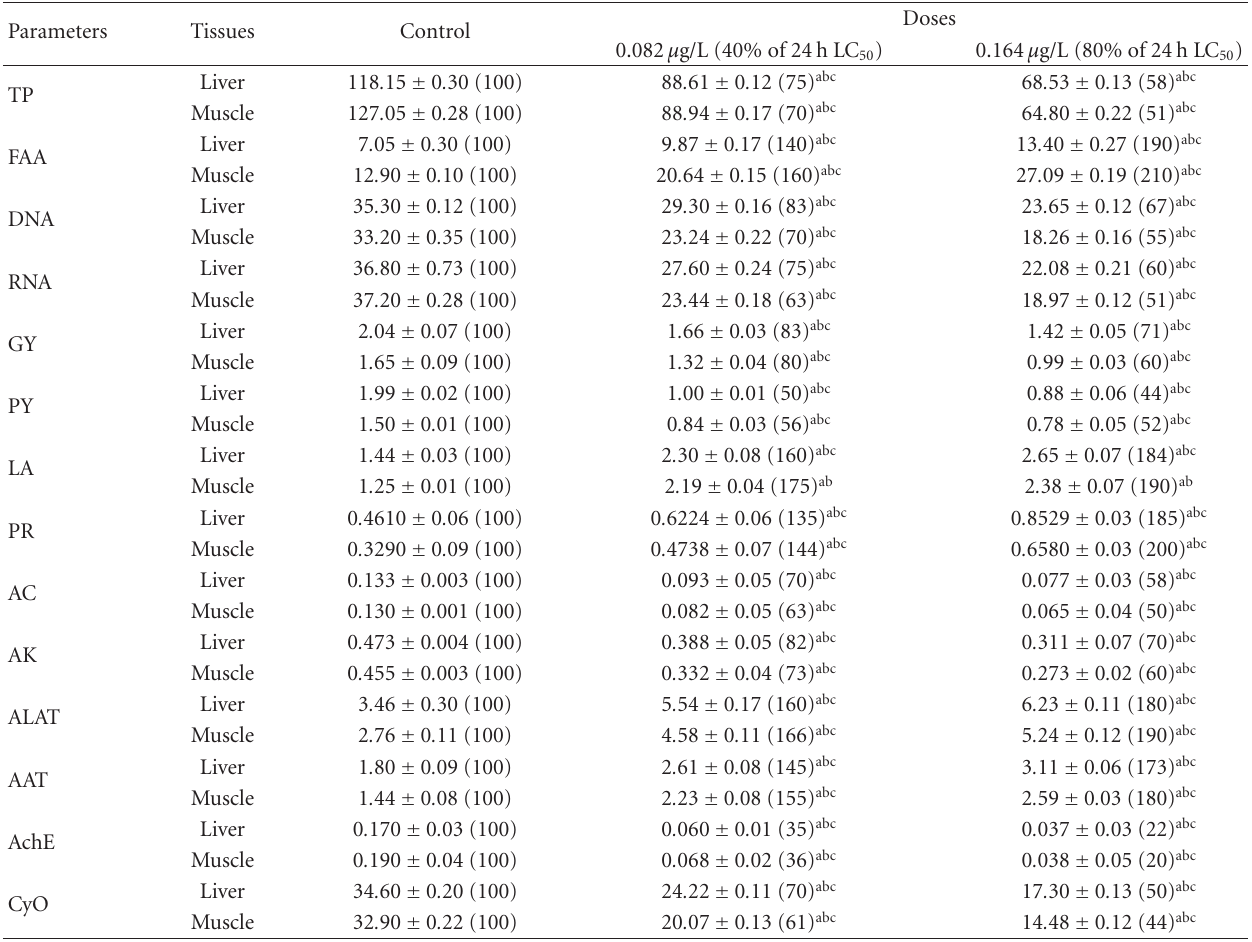
Table 3: Results of exposure of fish Labeo rohita fingerlings to cypermethrin for 96 h exposure periods.